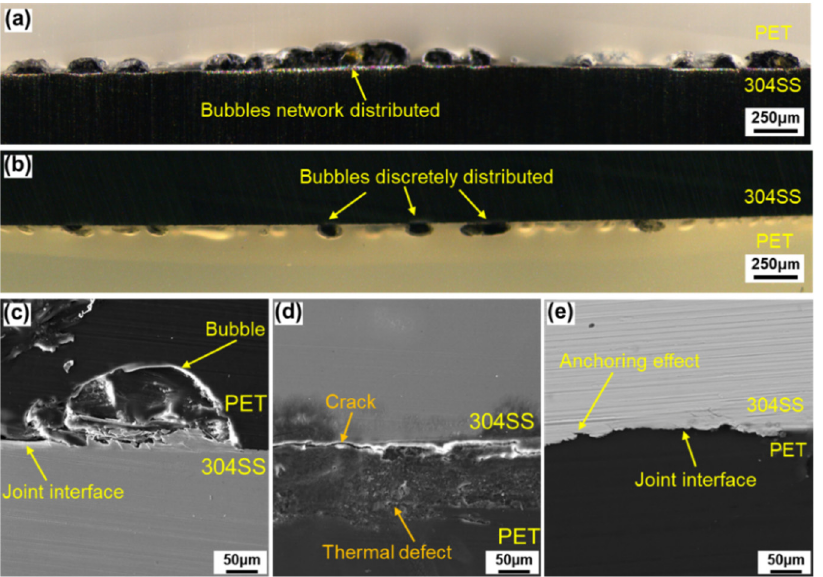
Figure 3. Cross-section of joints: ( a ) bubble distribution of O-LTJ, ( b ) bubble distribution of O-LCJ, ( c ) bubble detail of O-LTJ, ( d ) thermal defect and crack of LCJ, ( e ) joining region of O-LCJ.